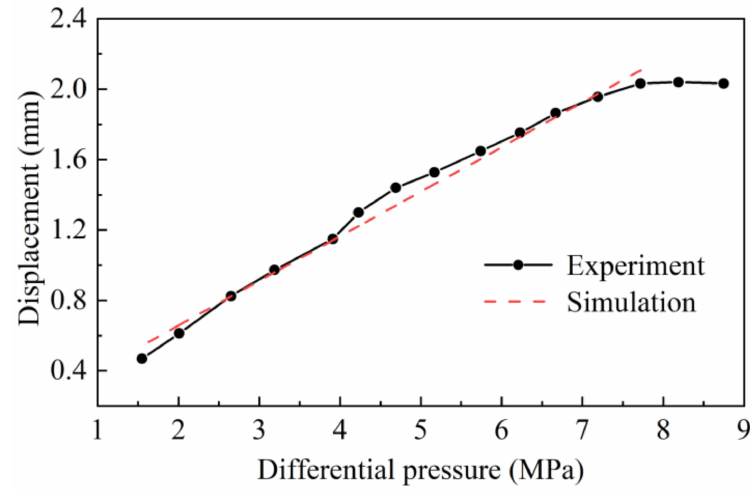
Figure 18. Displacement–differential pressure curve.